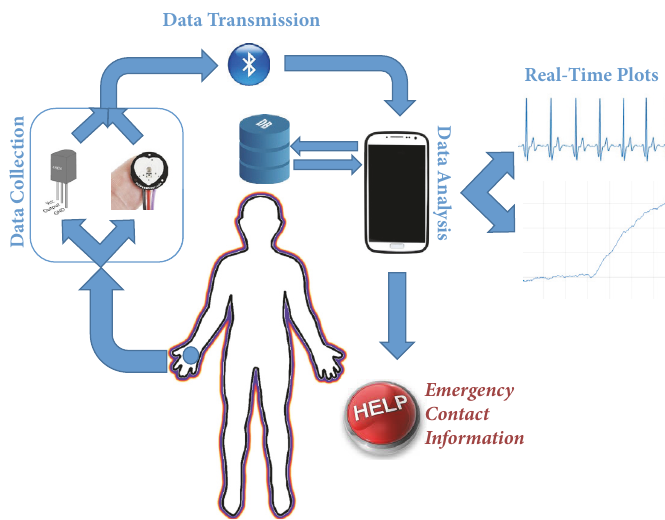
Figure 1: Proposed system architecture.